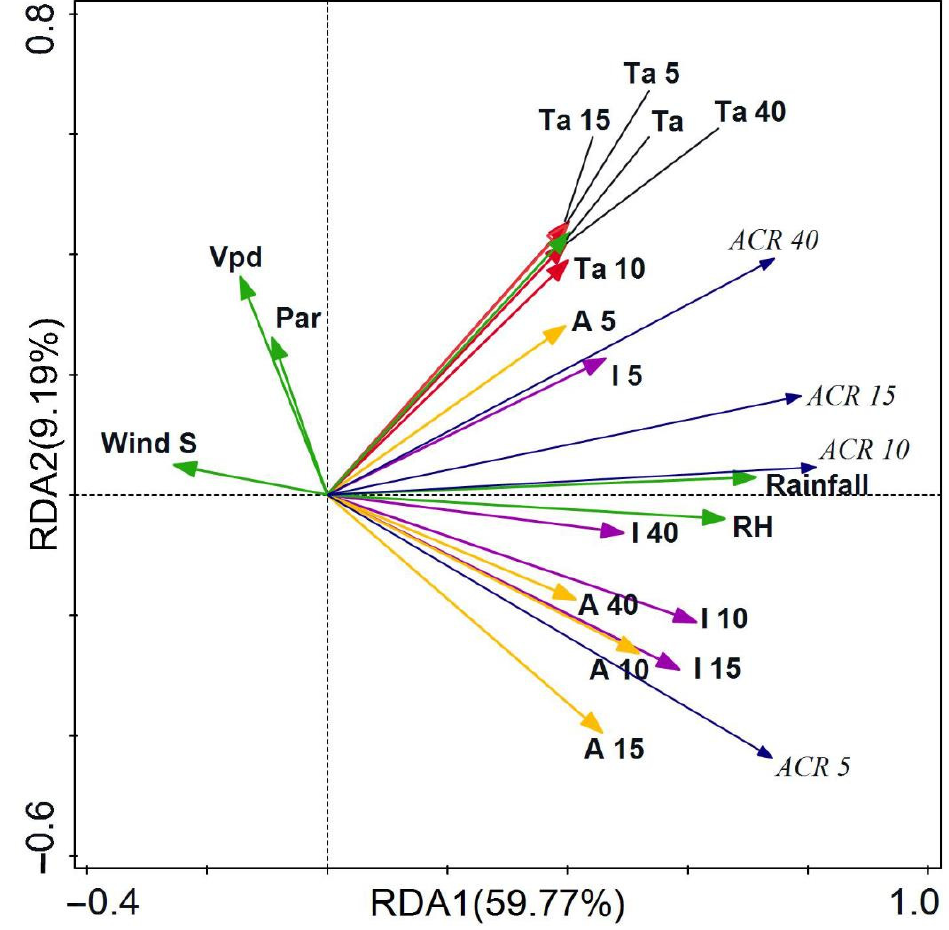
Figure 10. Redundancy analysis (RDA) of the absolute values in the change rates of soil moisture content, soil temperature, soil moisture, and environmental factors. The angles and lengths of arrows indicate the direction and strength of the relationship of the rate of change of soil moisture content, soil temperature, soil moisture, and environmental factors. ACR5, ACR10, ACR15, and ACR40 (blue), respectively, represent the absolute values of the rates of change of the soil moisture content in the 5 cm, 10 cm, 15 cm, and 40 cm soil layers; Ta 5, Ta 10, Ta 15, and Ta 40 (red), respectively, represent the soil temperature in the 5 cm, 10 cm, 15 cm, and 40 cm soil layers; I 5, I 10, I 15, and I 40 (violet), respectively, represent the initial moisture content in the 5 cm, 10 cm, 15 cm, and 40 cm soil layers; A 5, A 10, A 15, and A 40 (yellow), respectively, represent the average moisture content in the 5 cm, 10 cm, 15 cm, and 40 cm soil layers; Par (green): daily mean photosynthetically-active radiation; Ta (green): daily mean air temperature; RH (green): mean air relative humidity; Vpd (green): mean vapor pressure deficit; Rainfall (green): cumulative rainfall; Wind S (green): daily mean wind speed.